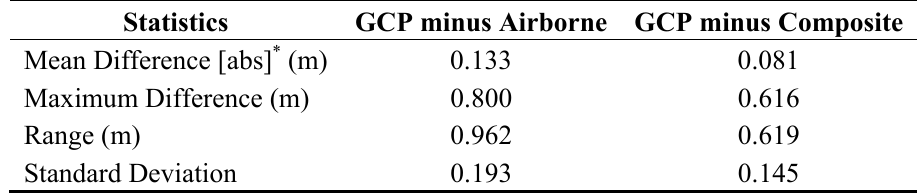
Table 2. Differences between the ground control point (GCP) elevation values and elevation values from the bare-earth airborne and composite LiDAR TIN datasets.